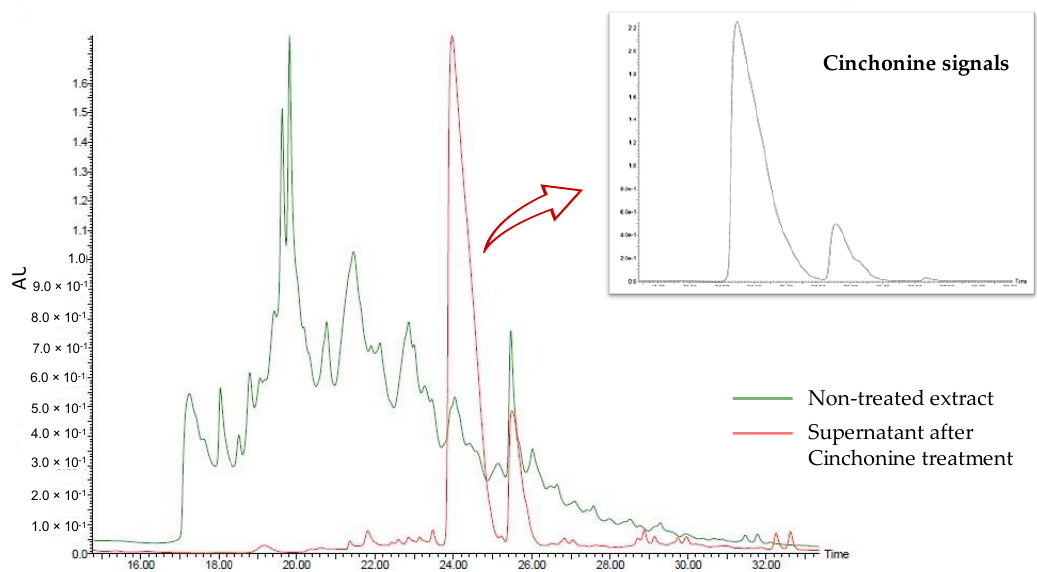
Figure A2. LC-MS analysis, comparison for cinchonine precipitation of tannins.